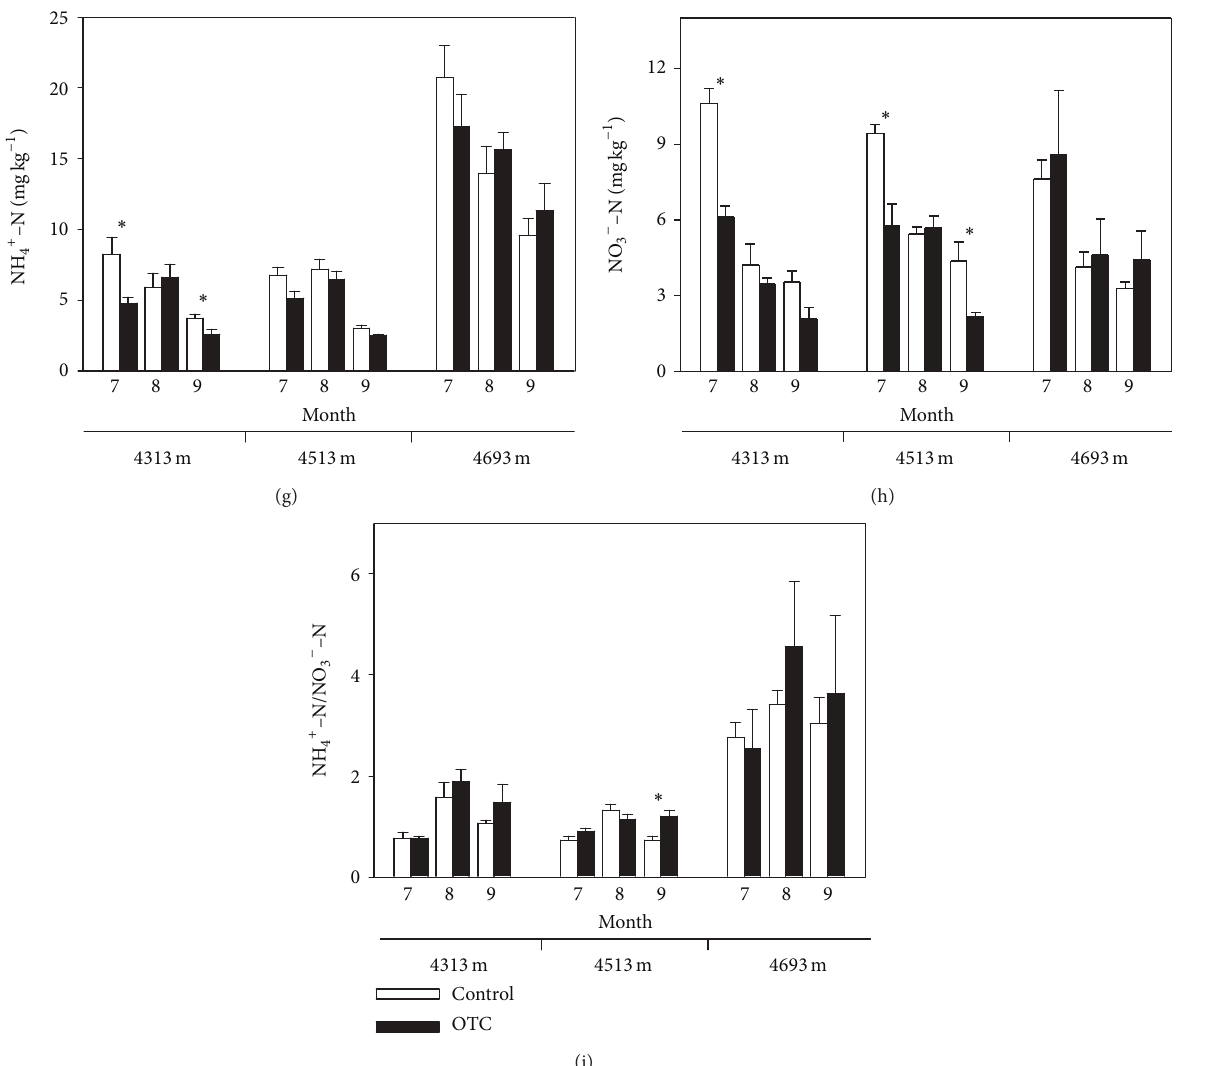
Figure 1: Effects of experimental warming on soil organic C (SOC), total N (TN), dissolved organic C (DOC), dissolved organic N (DON), the ratio of DOC to DON (DOC/DON), soil inorganic N (N min ), ammonium N ( NH 4+ -N ) , nitrate N ( NO 3− -N ) , and the ratio of NH 4+ -N to NO 3− -N ( NH 4+ -N / NO 3− -N ) in the three alpine meadow sites located at elevation 4313 m, 4513 m, and 4693 m, respectively (mean ± SE, 𝑛 = 4 ). ∗ indicates 𝑃 < 0.05 , while no asterisk indicates not